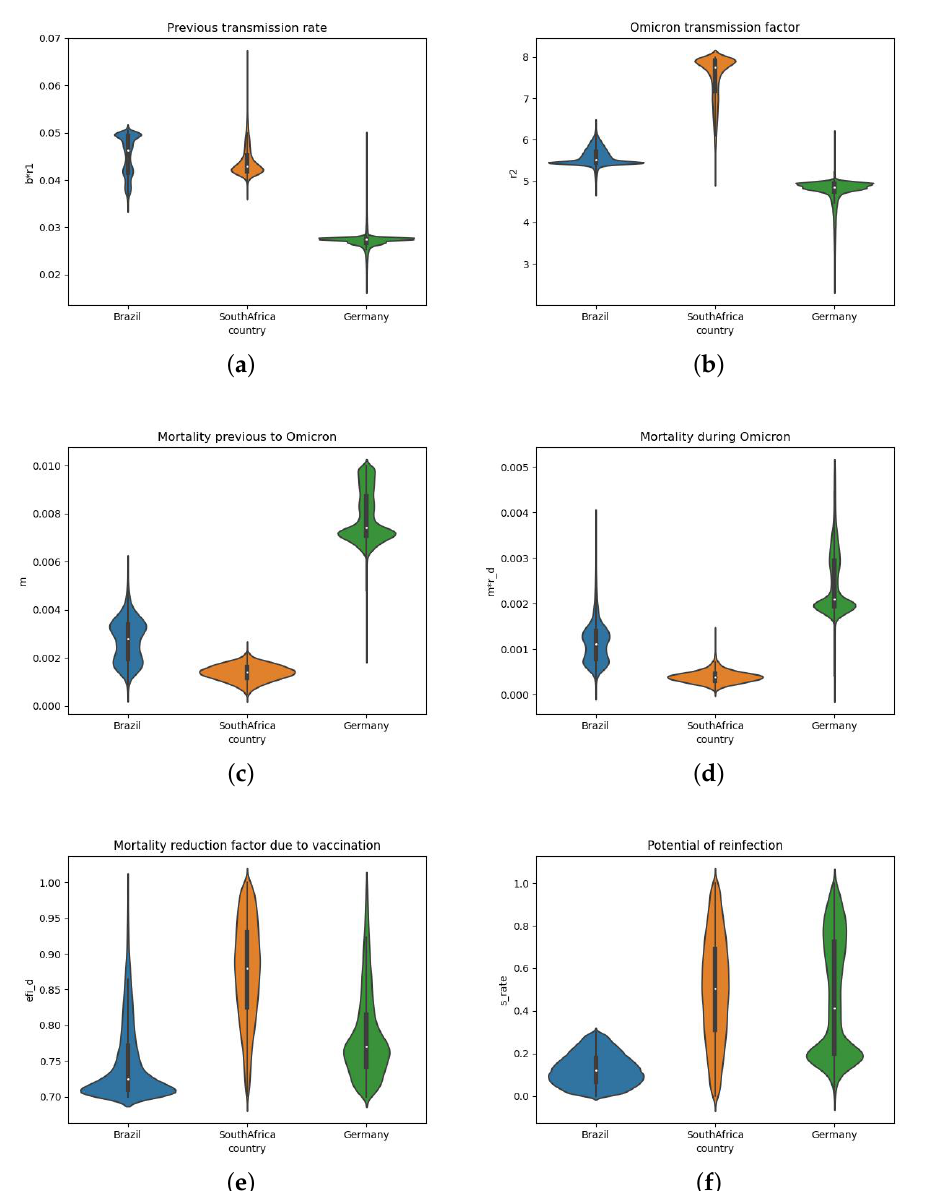
Figure 7. Violin plots of the parameters: b r 1, r 2, m , m r d , ef f d , s rate for Brazil, South Africa,